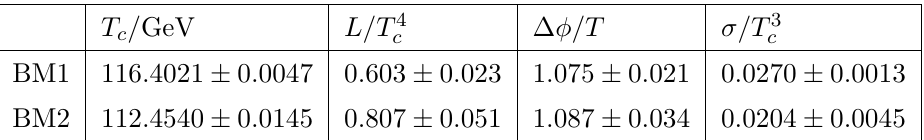
Table 4. Nonperturbatively determined critical temperature, latent heat, order parameter discon- tinuity and surface tension of the phase transition. The errors shown here are statistical errors of least square polynomial (cid:12)tting.